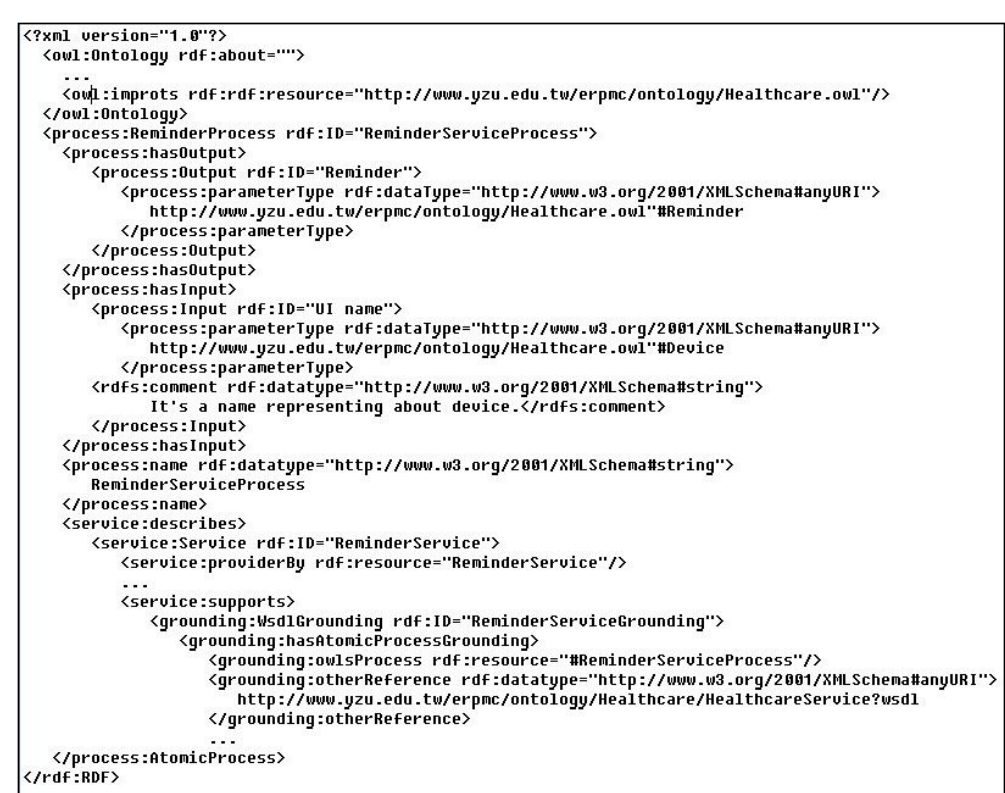
Figure 6. OWL-S description of the reminder